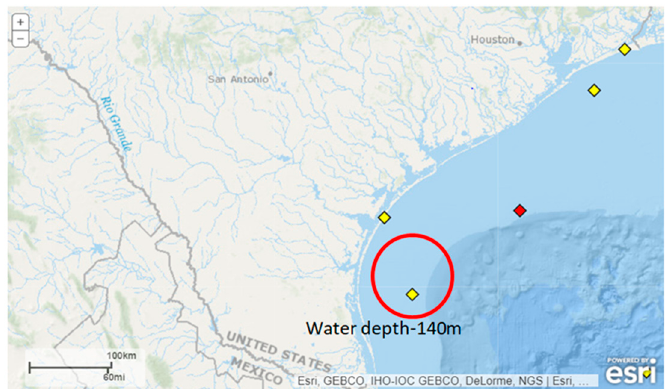
Figure 4. Weather buoy location. Table 1. Percentage ocean wave height and period occurrence.